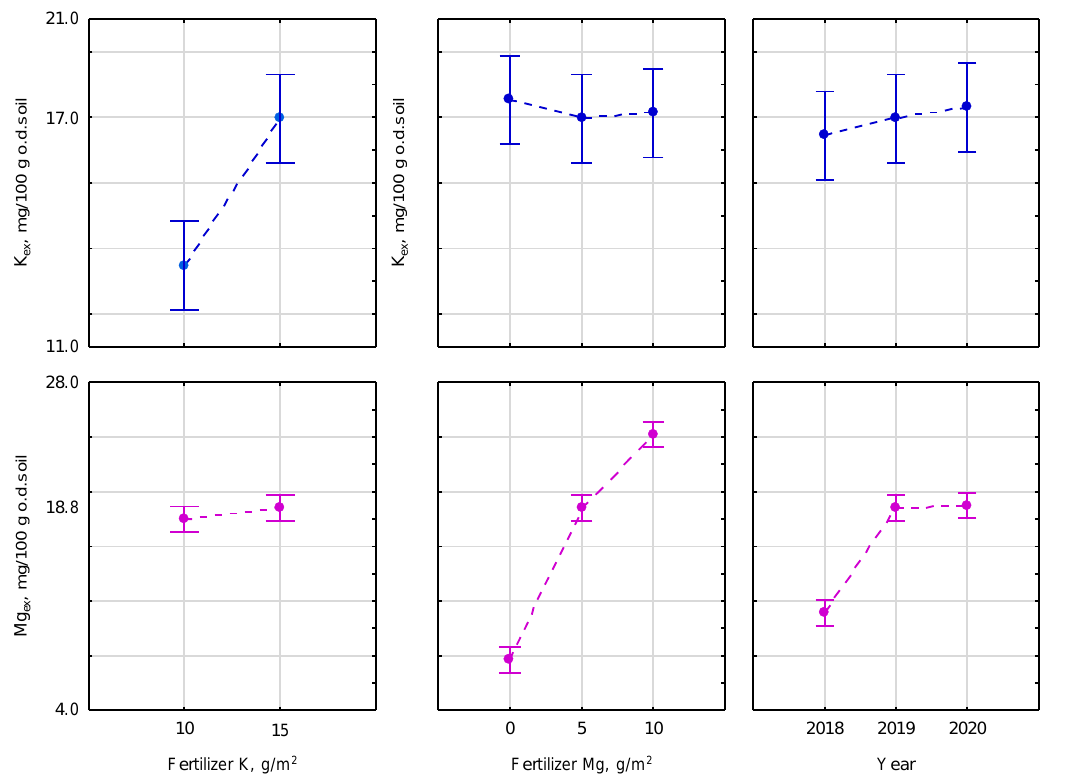
Figure 2. Profiles for predicted values of Kex and Mgex according to the GLM model (R 2 = 0.69 for Kex and R 2 = 0.98 for Mgex). Abbreviations: Kex—soil exchangeable K content, Mgex—soil exchangeable Mg content. Whiskers denote confidence intervals.